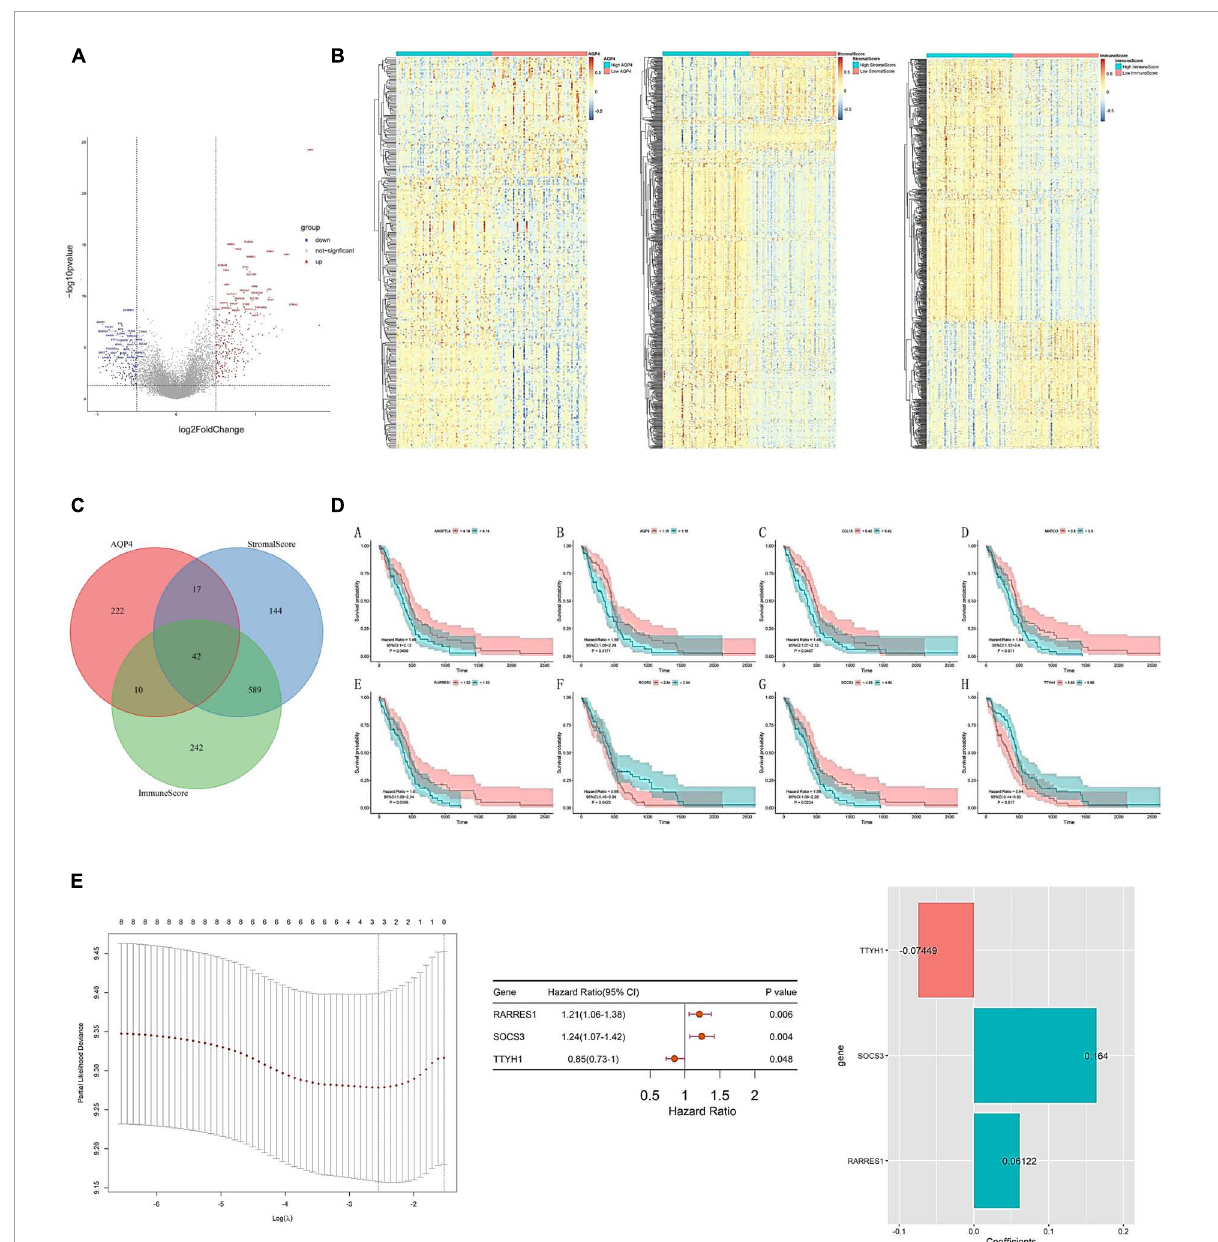
FIGURE6 Construction of AQP4 gene-related clinical prognosis model. (A) Volcano plot of differential genes between AQP4 high and low expression groups. (B) The differential gene heat map of the high and low AQP4 gene expression group, the high and low immune score group, and the high and low matrix score group. (C) The intersection of differential genes in high and low AQP4 gene expression group, high and low immune score group, and high and low matrix score group. (D) Survival analysis of eight (A–H) prognostic factors. (E) Construction of a predictive risk scoring